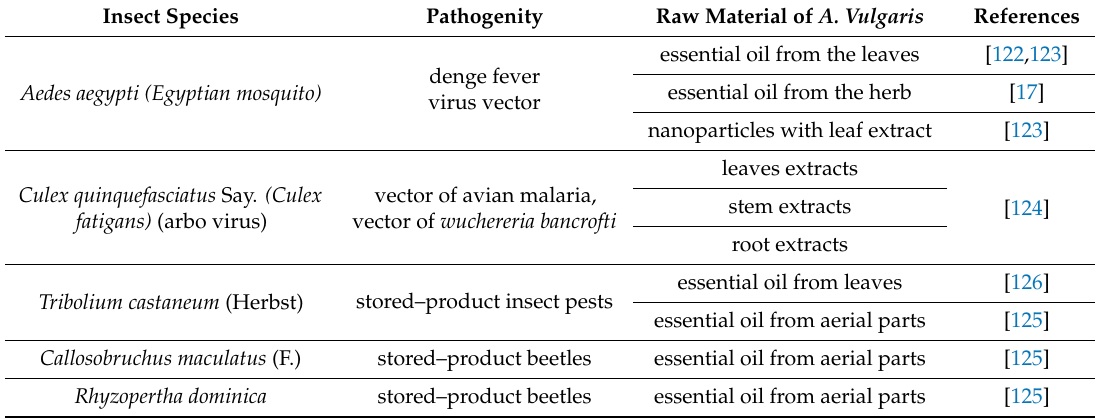
Table 6. Insecticidal activity of di ff erent raw materials from A. vulgaris